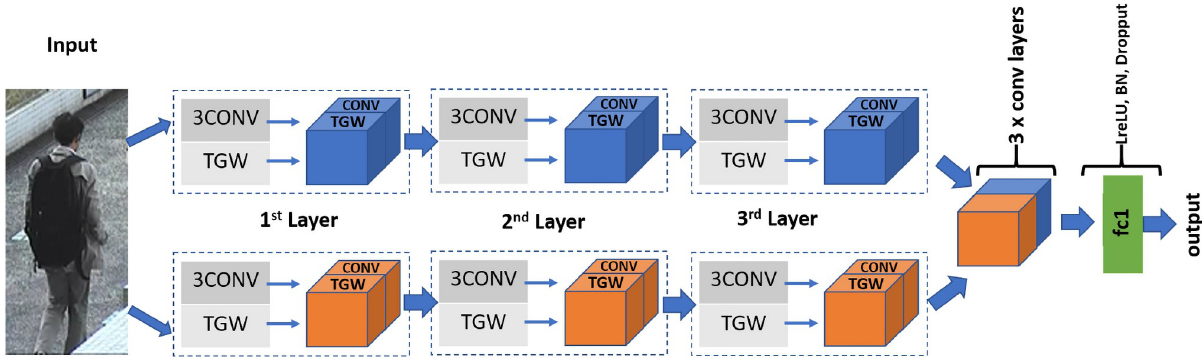
Fig 3. Our approach: The input is passes through two branches in the network. For each branch, the network contains 3 mixed-layers (combination of TGW and 3Conv layer). The output of each branch is followed by three convolutional layers and a fc layer. Size of the last layer of the network matches the number of attributes of the dataset. Parameters of the network are mentioned in Table 1.